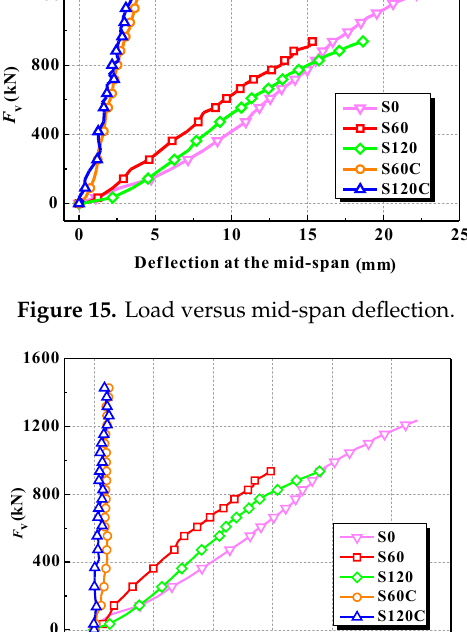
Figure 18. The following observations were